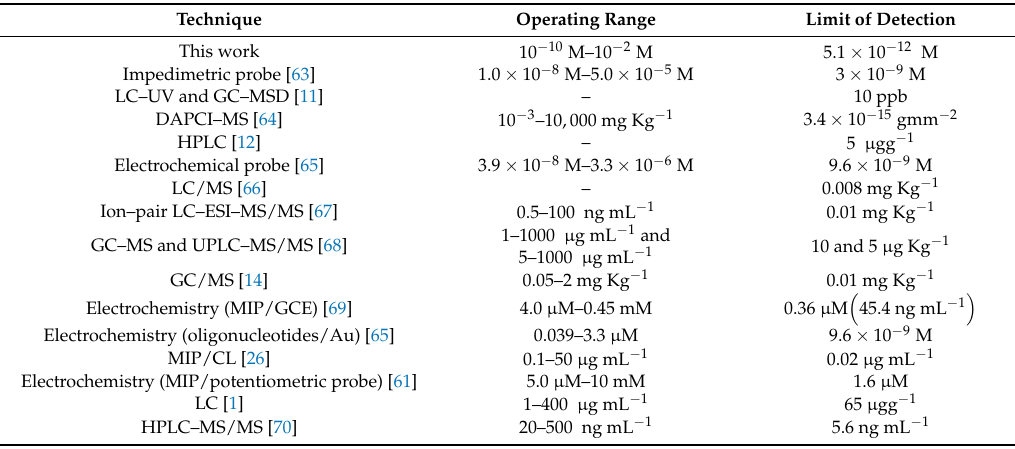
Table 2. Limit of detection and operating range of various approaches for melamine reported in previous study.